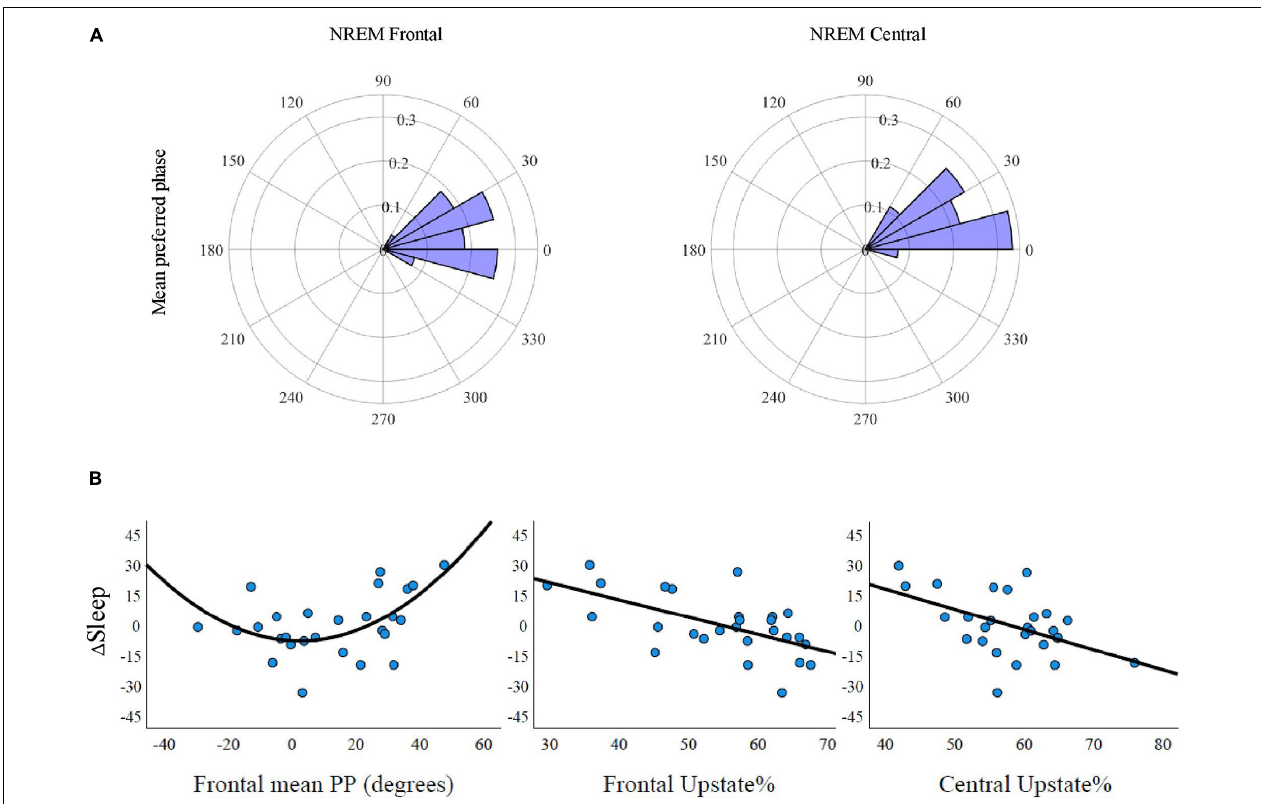
FIGURE 4 | Mean preferred phase and memory outcomes. (A) Circular histograms of individual mean preferred phase angles of spindle peak amplitude in a slow oscillation (SO) cycle for frontal and central SO–spindle complexes. The mean angles were non-uniformly distributed in frontal ( p < 0.001) and central ( p < 0.001) electrodes and showed a tendency to cluster near SO upstate (i.e., 0 ◦ ). There were no statistically significant differences in preferred phase between the frontal and central areas ( p = 0.110). (B) The coupling accuracy between SO upstate and spindle peak amplitude in predicted overnight memory retention. (cid:49) Sleep, reflecting overnight forgetting, was associated with the frontal mean circular direction (left; p = 0.019) and with the frontal and central percentage of SO–tied spindles peaking at the SO upstate ( ± 45 ◦ ) ( p < 0.001 and p = 0.008,